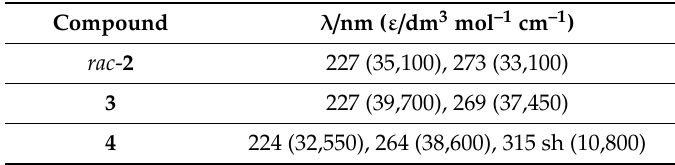
Figure 3. Solution absorption spectra of the isomeric compounds 1 (MeCN, 3.3 × 10 –5 mol dm –3 ), rac - 2 , 3 and 4 (MeCN, 2.0 × 10 –5 mol dm –3 ). Table 1. Solution absorption maxima (MeCN, 2.0 × 10 − 5 mol dm − 3 ) for compounds rac - 2 , 3 and 4 .